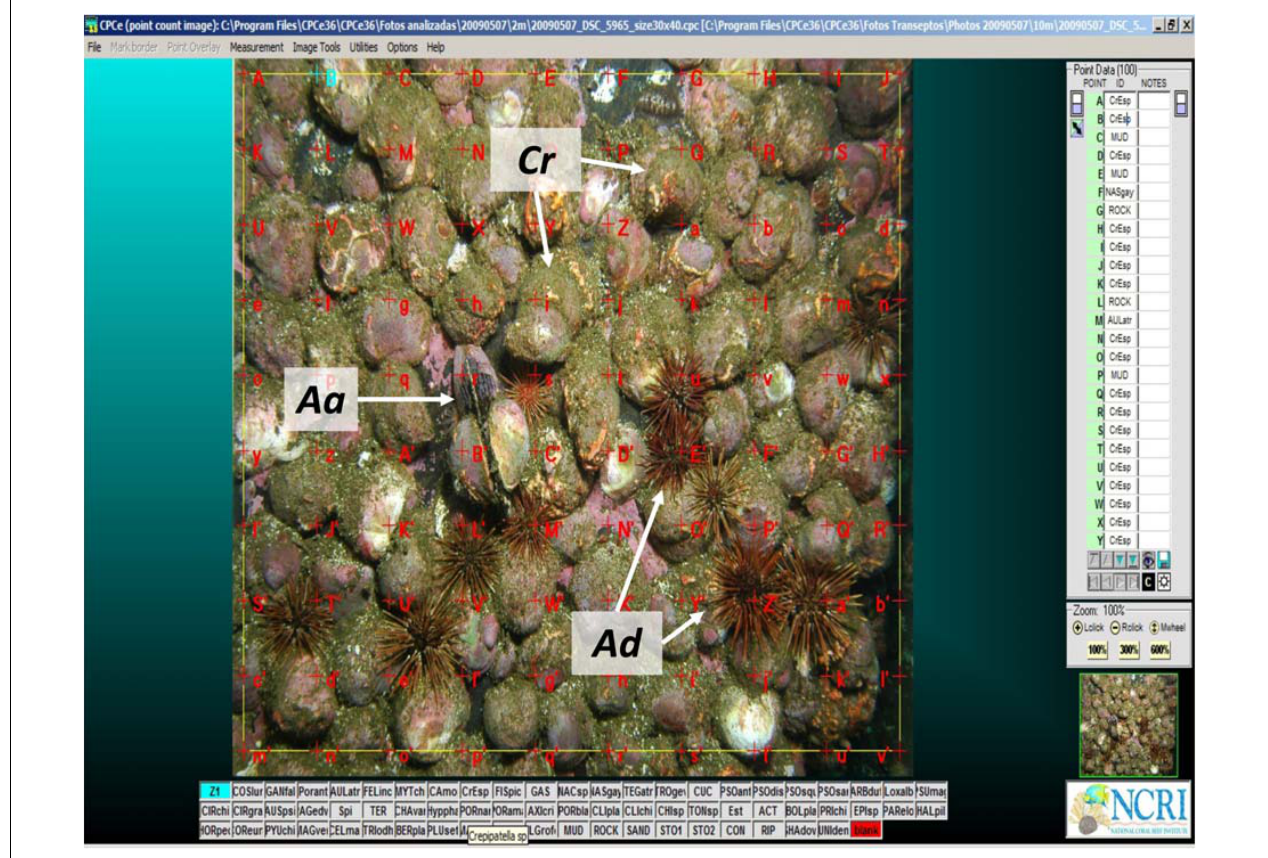
FIGURE 3 | Image analysis of photo-quadrats (example from 10-m depth) with red crosses indicating the matrix of uniform 10 × 10 points used to assess potential prey abundance. The mussel Aulacomya atra ( Aa ), the sea urchin, Arbacia dufresnii (Ad), and the slipper limpets Crepipatella spp. ( Cr ) are easily identified in the